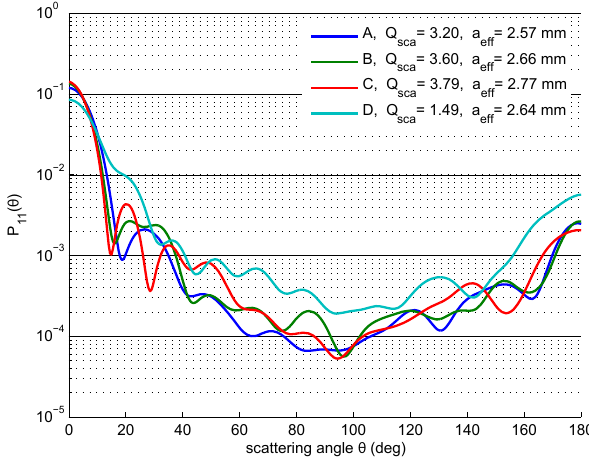
Fig. 7. DDA phase function calculations for the hydrometeors shown in Fig. 5, assuming a mesh of ice and a vacuum for 1.64mm wavelength (183GHz) incident